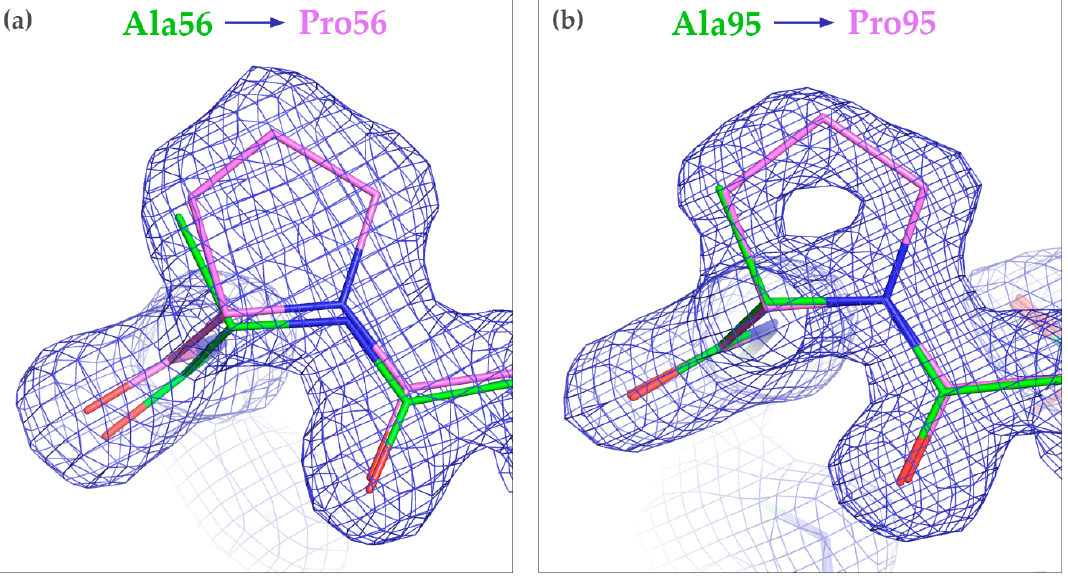
Figure 4. Effects of mutations A56P ( a ) and A95P ( b ) on the structure of CagFbFP. The backbone structure is essentially unchanged. The original structure of CagFbFP (PDB ID 6RHF) is shown in green, while the structures of the mutants are shown in magenta. 2F o -F c electron densities (blue) are contoured at the level of 1.5 × r.m.s.